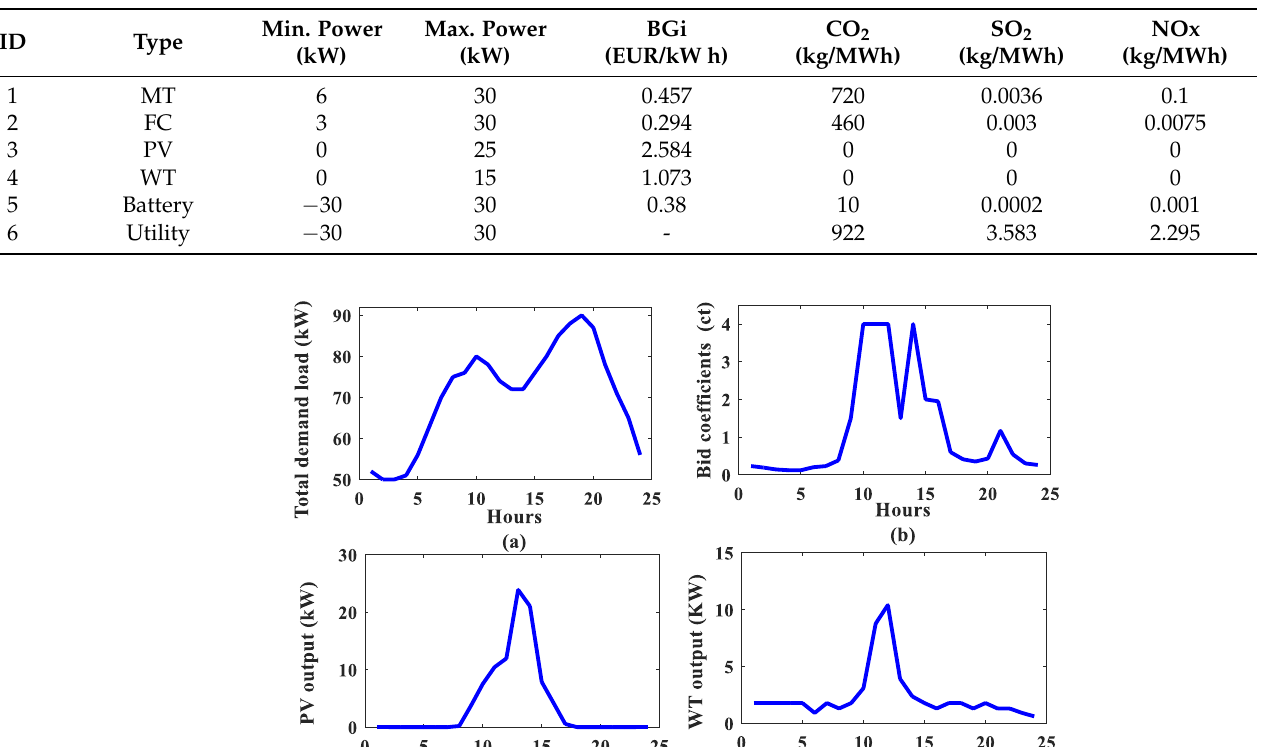
Table 1. The power limitations, bid coefficients, and emissions of the MG sources.